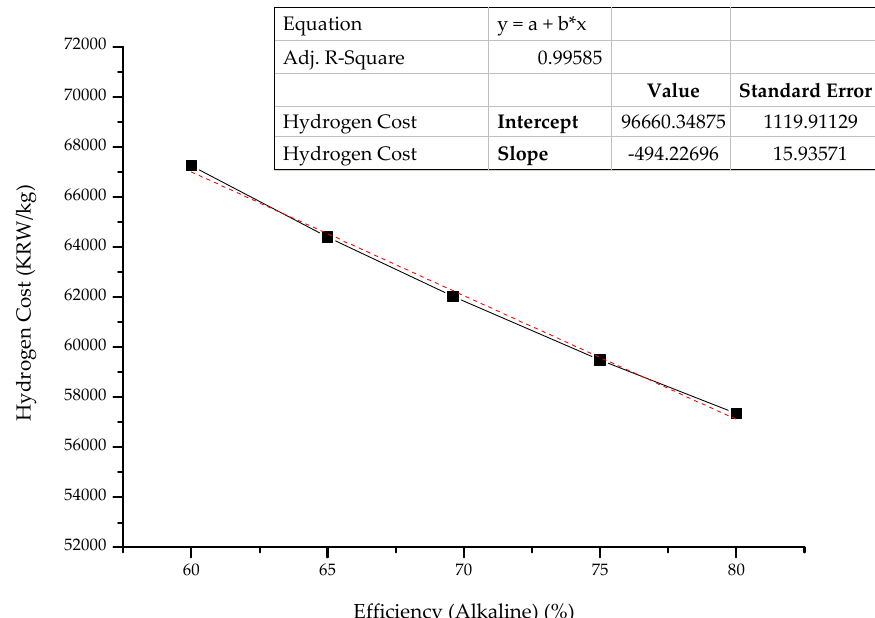
Figure 5. Correlation between efficiency of water electrolysis (alkaline type) and hydrogen cost *. * x -axis: Efficiency for Alkaline-Type Water Electrolysis (%), y -axis: Hydrogen Cost (KRW/kg). Solid line: y-values connecting line, Dot line: Regression line.